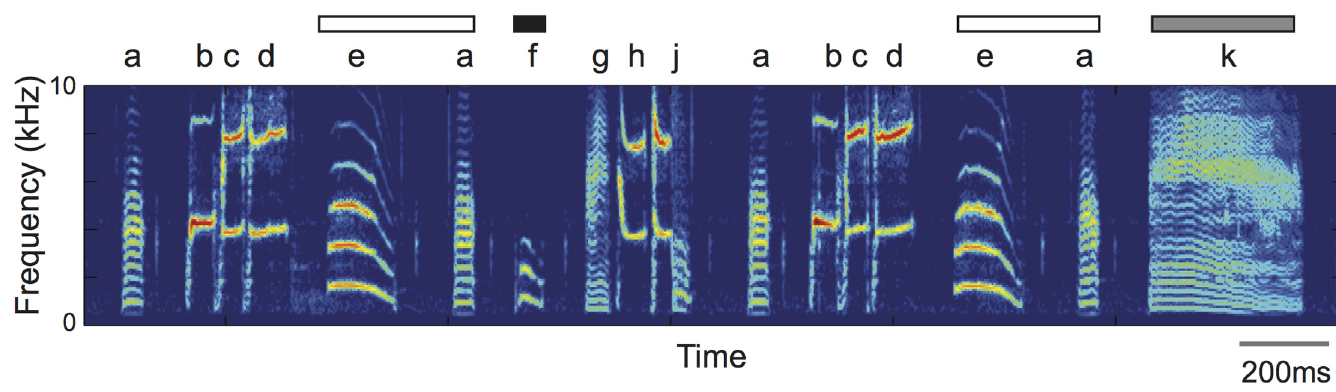
Fig 1. Bengalese finch song. Bengalese finch song consists of distinct acoustic elements ( ‘ syllables ’ ) that are arranged into stereotyped sequences as well as sequences that vary in transitions from rendition to rendition ( ‘ branch points ’ ). Depicted is a spectrogram (frequency on the y-axis, time on the x-axis, color as intensity) of a single rendition of an adult Bengalese finch song, with letters labeling individual syllables in the song. In this example, the sequences ‘ bcd ’ and ‘ ghj ’ are stereotyped sequences. The sequence ‘ ea ’ is a branch point because transitions from ‘ ea ’ vary across renditions: the bird transitions to ‘ f ’ 90% of the time and ‘ k ’ 10% of the time. We analyzed how the probabilities of individual syllable transitions co-varied with the duration of silent gaps between syllable transitions (e.g., gaps between ‘ a ’ and ‘ k ’ and between ‘ a ’ and ‘ f ’